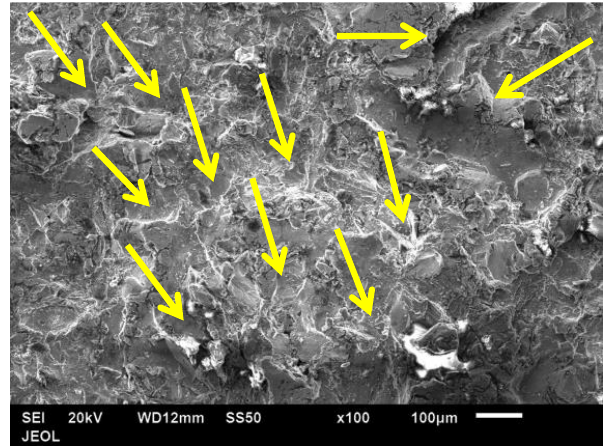
Figure 1. Substrate surface after subjection to grit blasting. Arrows show dents occurring due to the impact of Al 2 O 3 powder.